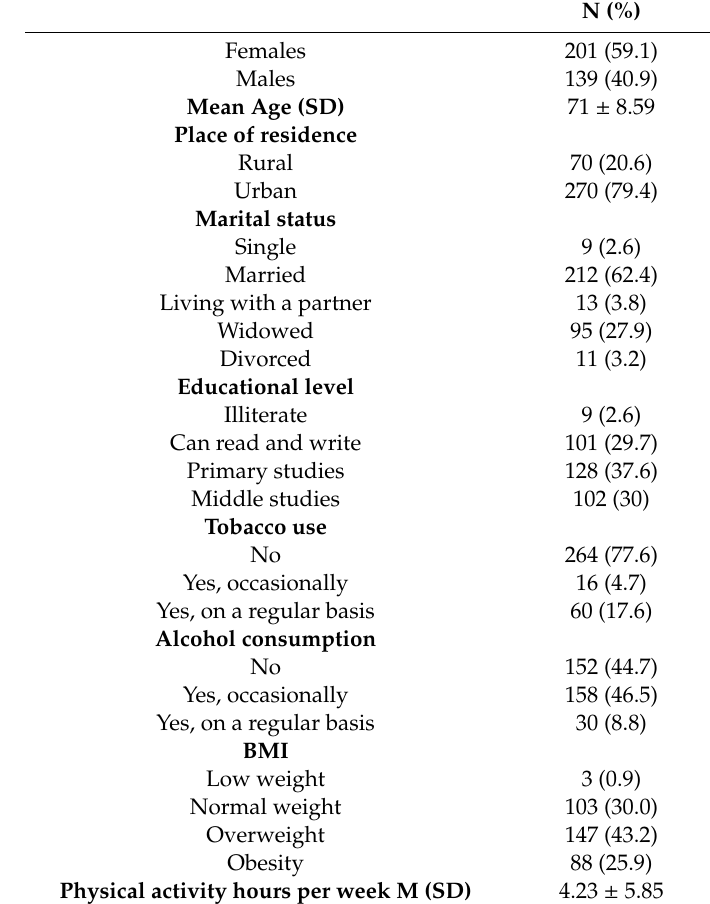
Table 1. Sociodemographic variables and lifestyle. SD—standard